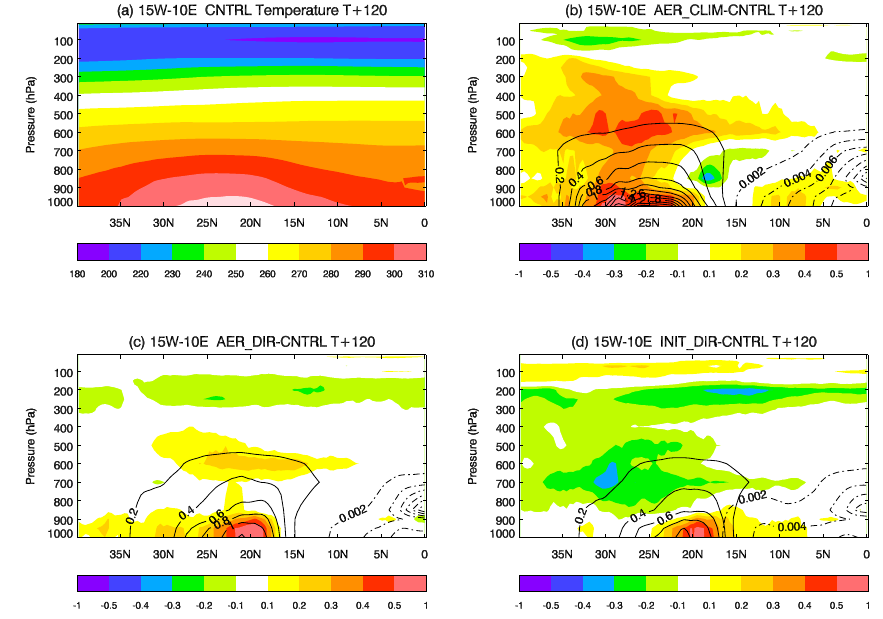
Fig. 21. Zonal cross-section of T + 120 mean temperature averaged between 15 ◦ W and 10 ◦ E: (a) CNTRL temperature, (b) CLIM-CNTRL, (c) AER_DIR-CNTRL, (d) INIT_DIR-CNRTL. Dust concentrations are shown in solid contour lines with intervals of 0 . 2 × 10 − 6 kgm − 3 . Biomass burning concentration are shown in dashed contour line with contour interval of 0 . 002 × 10 − 6 kgm − 3 . are also provided daily to the World Meteorological